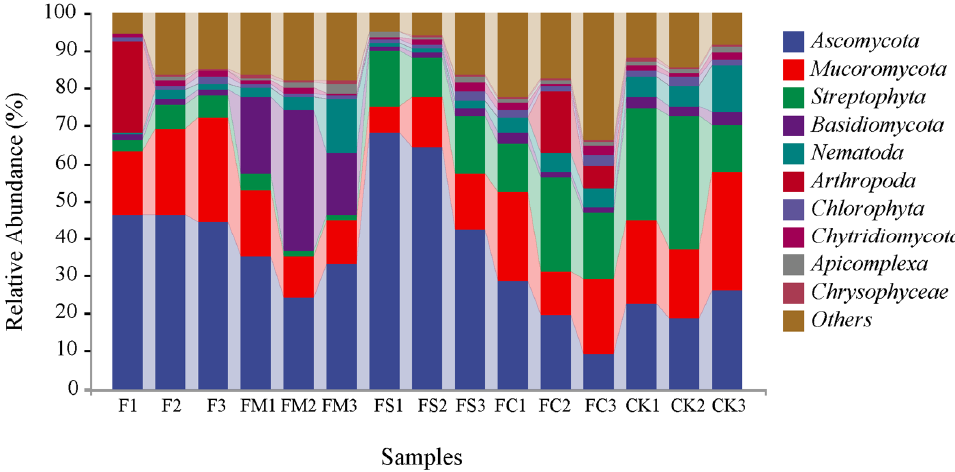
Figure 2. Relative abundance of eukaryotic microorganisms at phylum level in different samples. Note: F: chemical fertilizer; FM: chemical fertilizer + cattle manure; FS: chemical fertilizer +